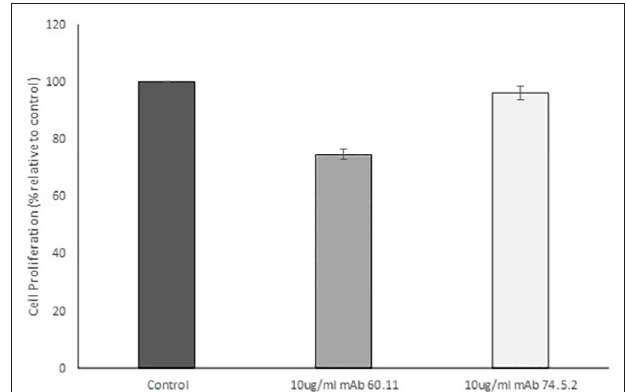
TABLE 2 | Effect of 60.11 therapy on mouse weight and blood cell counts.